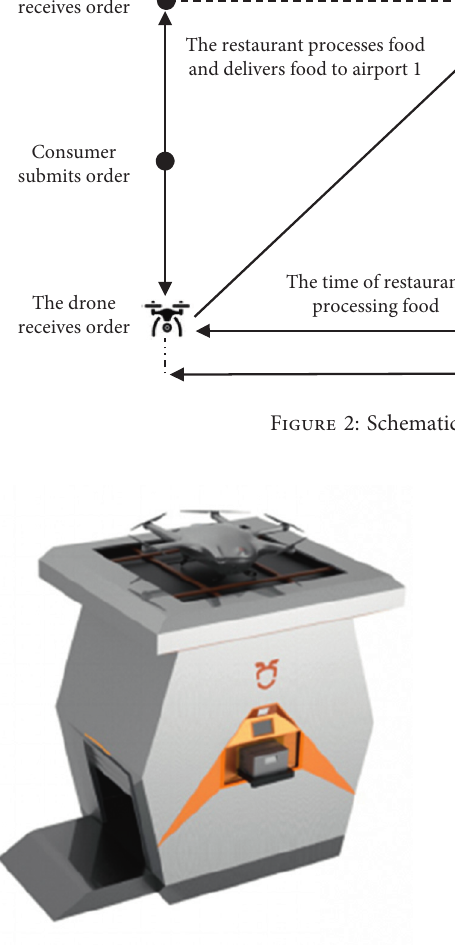
Figure 3: Schematic diagram of drone